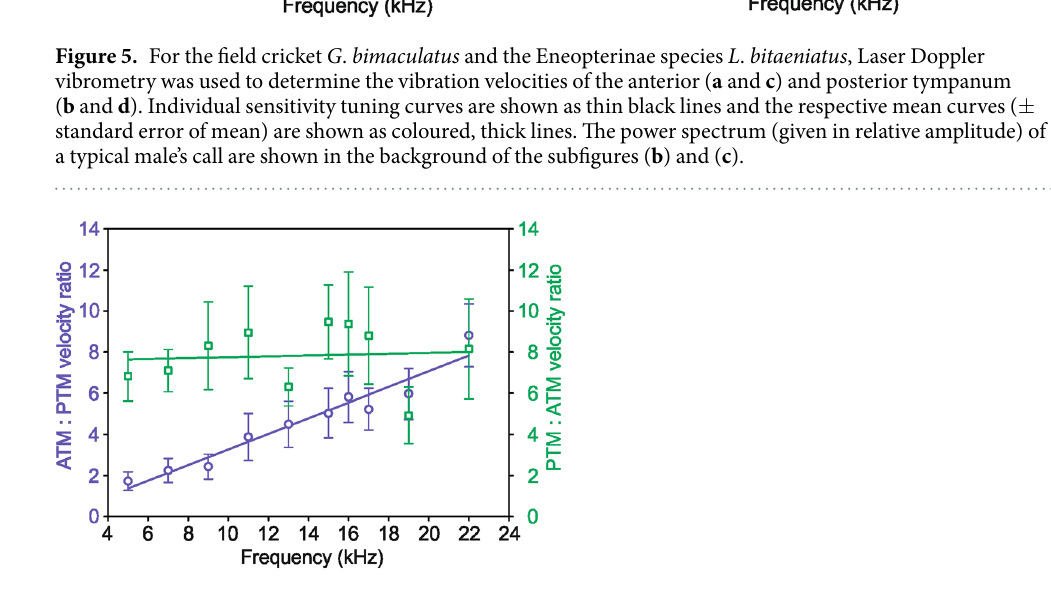
the PT in all investigated Eneopterinae species (Table 1). Thus, this larger tracheal volume might create greater displacement on the lateral side of the anterior trachea where the sensory cells are attached. In the comparison of field crickets, tree crickets and the eneopterines made here, it is obvious that both, the ATM and PTM contribute to the hearing process, albeit to different degrees. Tree crickets supposedly have two equally functional TMs, whereas the main tympanal input is provided by the PTM in field crickets and by the ATM in L . bitaeniatus (and perhaps in most eneopterines that possess similar ATM morphology). The subfamily Eneopterinae has been subdivided into two main groups: the Eurepini and a second, larger group that encompasses the tribes Eneopterini, Nisitrini, Xenogryllini and Lebinthini 40 . The Eurepini only have a PTM, whereas all other tribes also possess an ultrathin ATM covered with a cuticular cap 28 . In contrast to